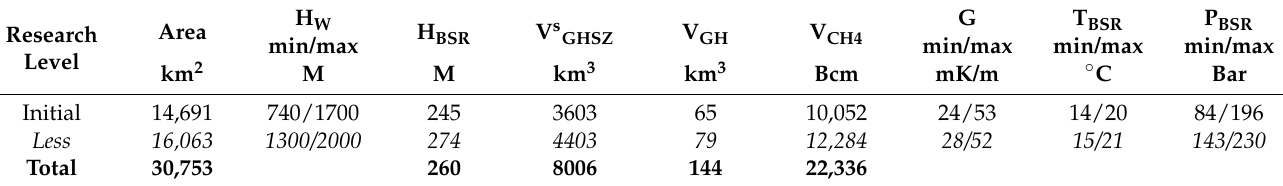
Table 2. Main physical parameters of the Black Sea GHDs (BSR